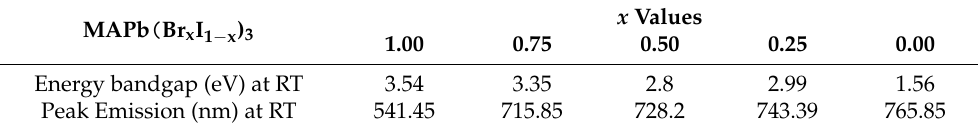
Figure 5. The absorbance values of MAPb(Br x I 1 − x ) 3 perovskite films. Table 3. The Band-gap values and Wavelength position of peaks at room temperature.